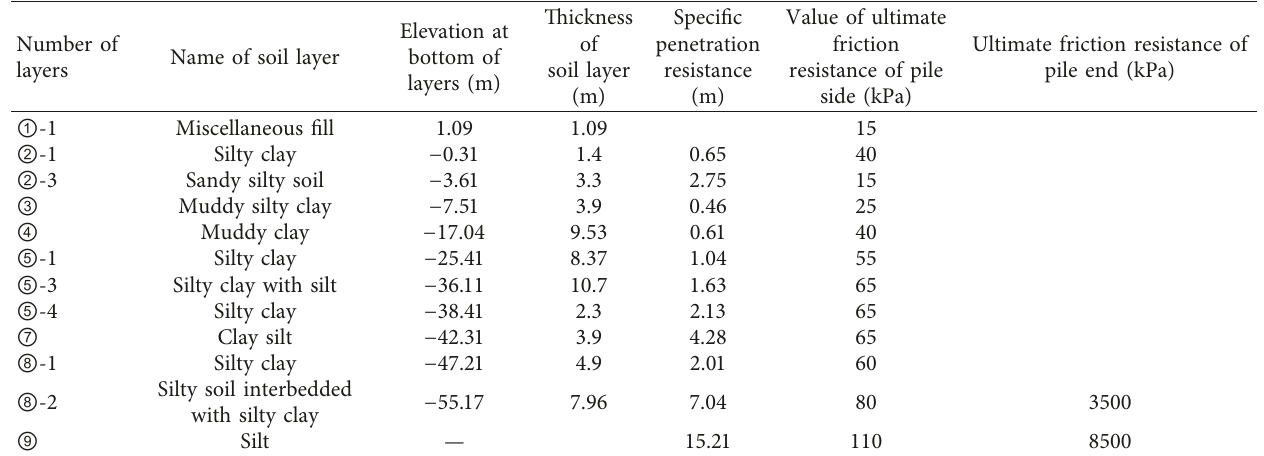
Figure 3: Embedding gauges and geometry size of test piles. (a) Embedding gauges of test piles. (b) Composition form of static drill rooted nodular pile (unit: mm). Table 1: Soil profile and parameters for the tested